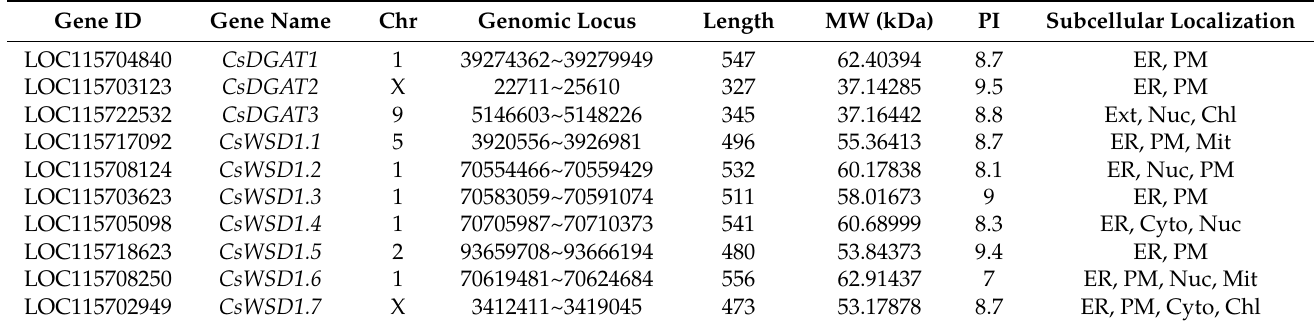
Table 1. Details of genome-wide identified DGAT family members in C. sativa .